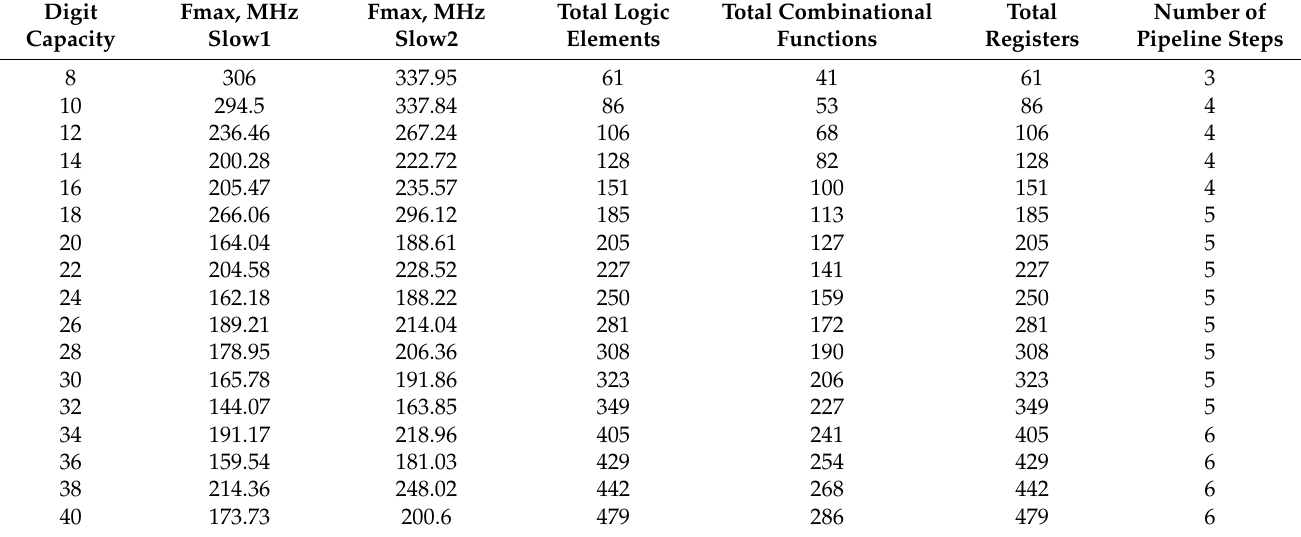
Table 6. Characteristics of the pipelined CCM implementing the modified Booth’s algorithm.